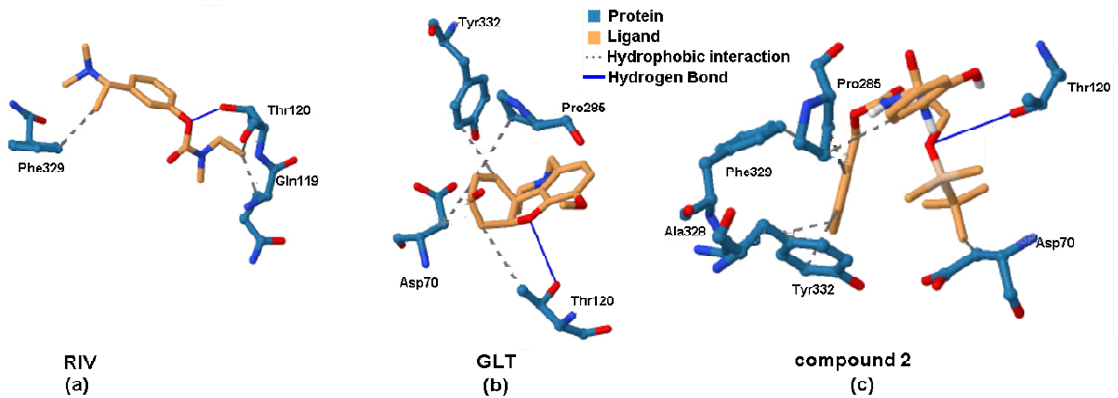
Figure 10. 3D-based comparison of the binding pattern for RIV ( a ), GLT ( b ) and the most active BChE inhibitor 2 , produced by PLIP program.